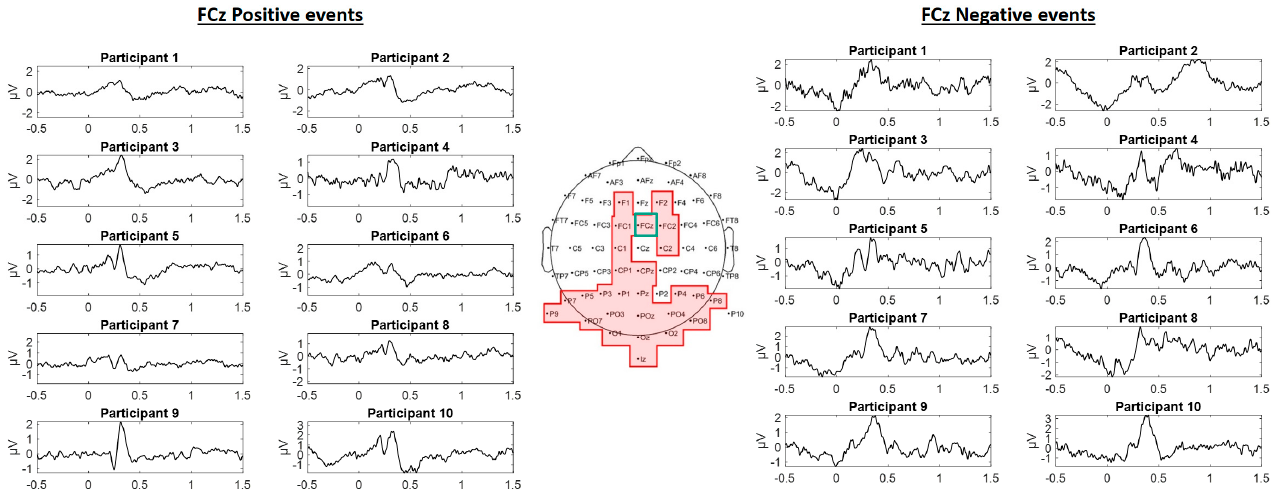
Figure 7. Time domain plots of FCz channel’s signals with a time window of 2.0 s, event onset at 0 s, as an example of patterns found on EEG signals in presence of game events for each of the participants.